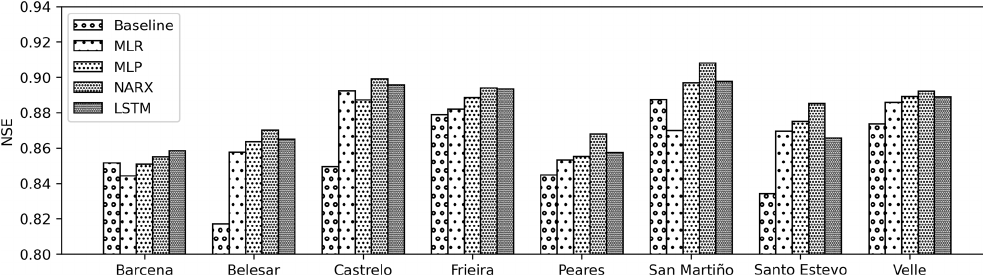
Figure 8. Bar chart comparing the NSE values for the test dataset for each reservoir and